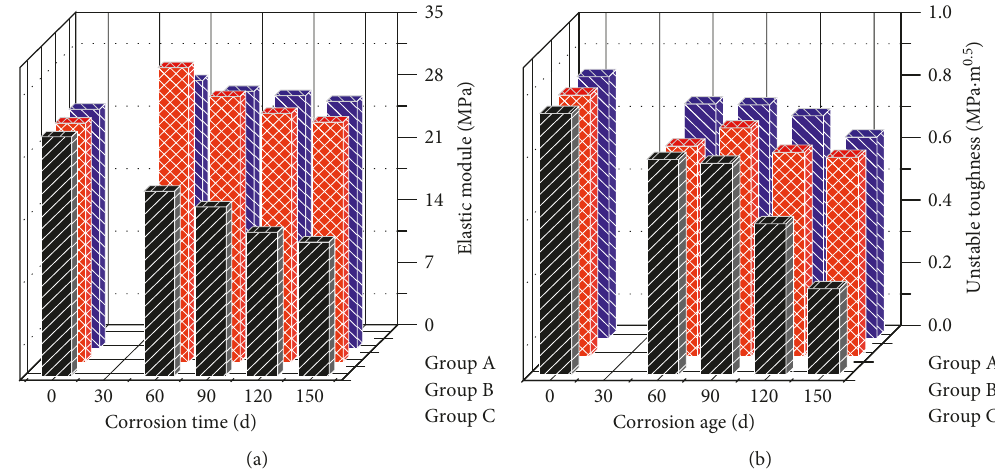
Figure 15: Elastic module and unstable fracture toughness at different corrosion time. (a) Elastic module; (b) unstable fracture